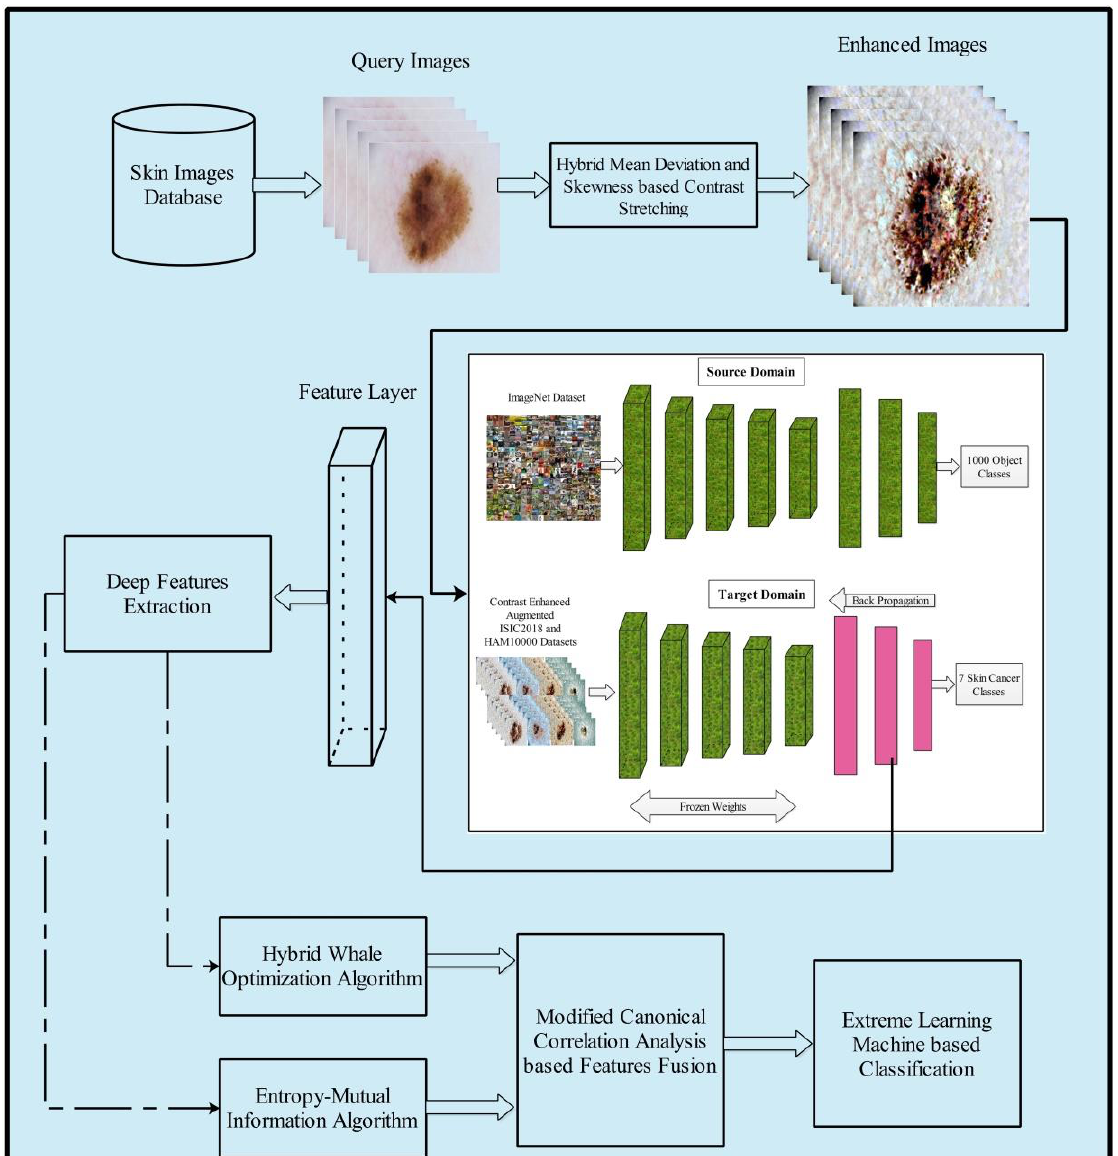
Figure 3. Proposed multiclass skin lesion classification using optimal deep learning features fusion.